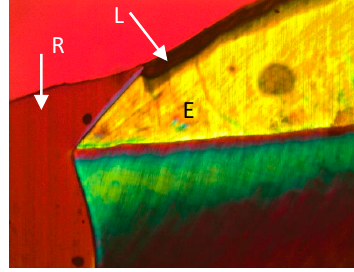
Figure 2. Z100 restoration in enamel at 10 times magnification (E—enamel, L—lesion, R—restoration).